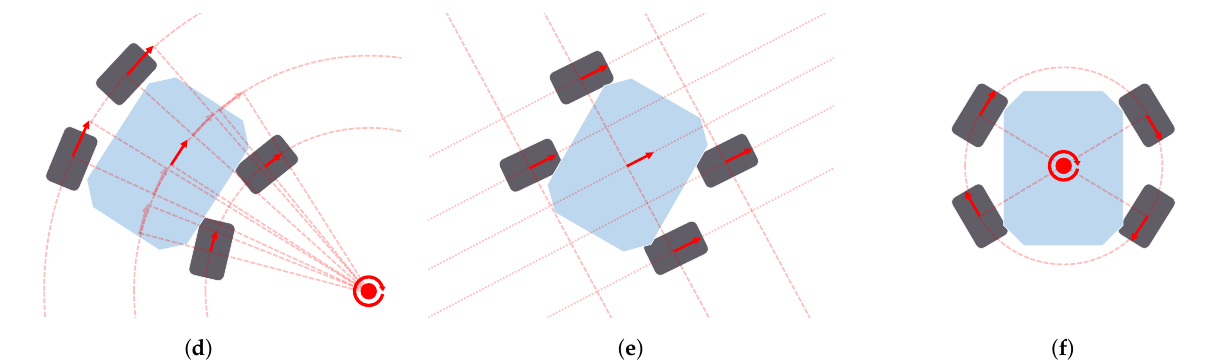
Figure 4. Locomotion models used for wheeled ground mobile robots along with path planners: Differential drive ( a ), Front Ackermann ( b ), Skid-steering ( c ), Full Ackermann ( d ), Crabbing ( e ) and Point Turn ( f